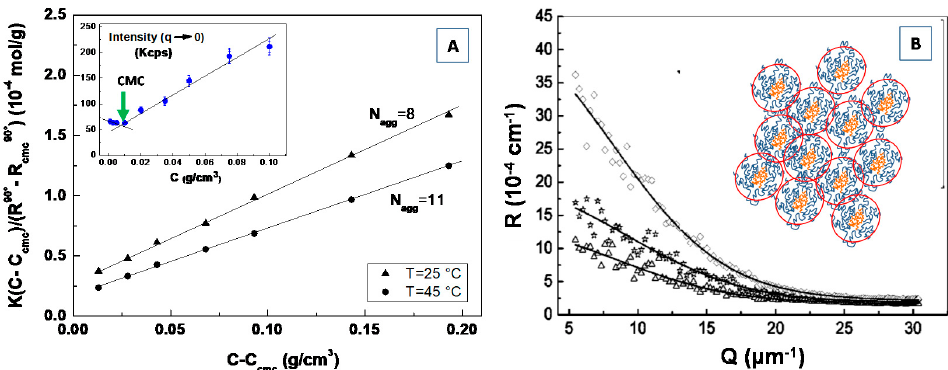
Figure 13. Analysis of the SLS for the water solution of PDMS-b-PEO block copolymer. Normalized inverse absolute intensity of micelles as a function of copolymer concentration at the two temperatures T = 25 ◦ C (triangles) And T = 45 ◦ C (squares), and the corresponding calculated mean aggregation number N agg of the micelles ( A ). Excess absolute intensity profile at T = 25 ◦ C at three di ff erent concentration: c = 0.05 g / cm 3 (up triangles), c = 0.1 g / cm 3 (stars), and c = 0.2 g / cm 3 (diamonds) ( B ). The continuous lines are the fit according to the polydisperse sphere form